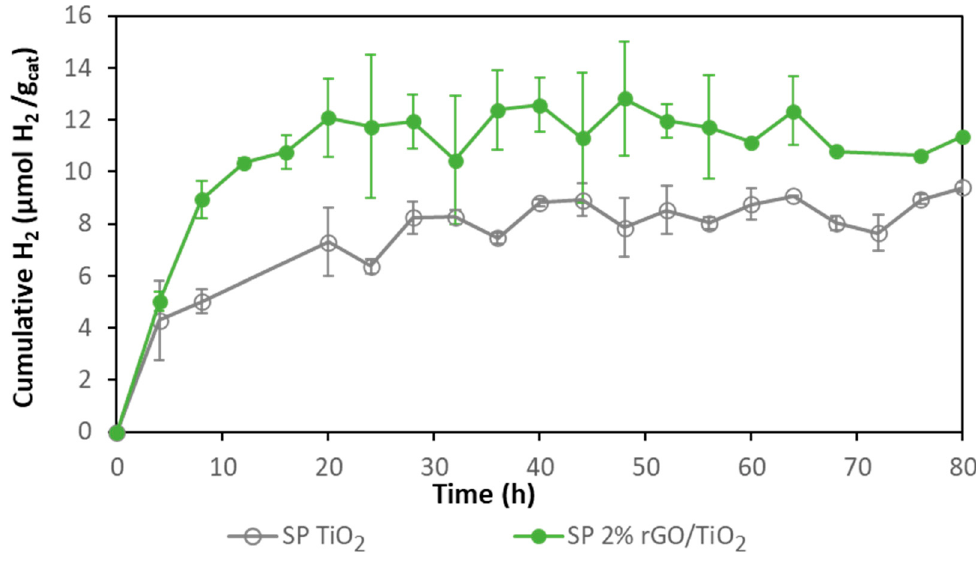
Figure 5. Comparison of hydrogen production with 2% rGO/TiO 2 SP and bare TiO 2 SP